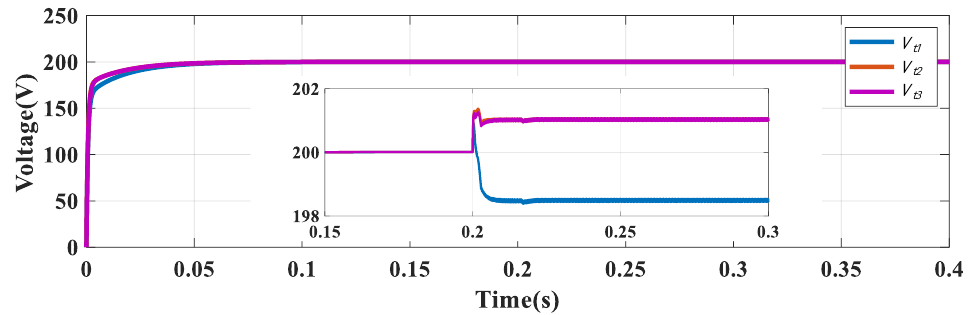
Figure 14. Study 2: output voltage of each DG.